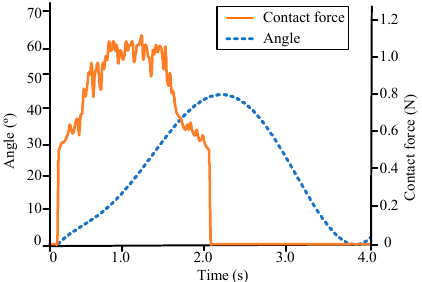
Figure 14. The comparison diagram of the angle values and the contact force values.